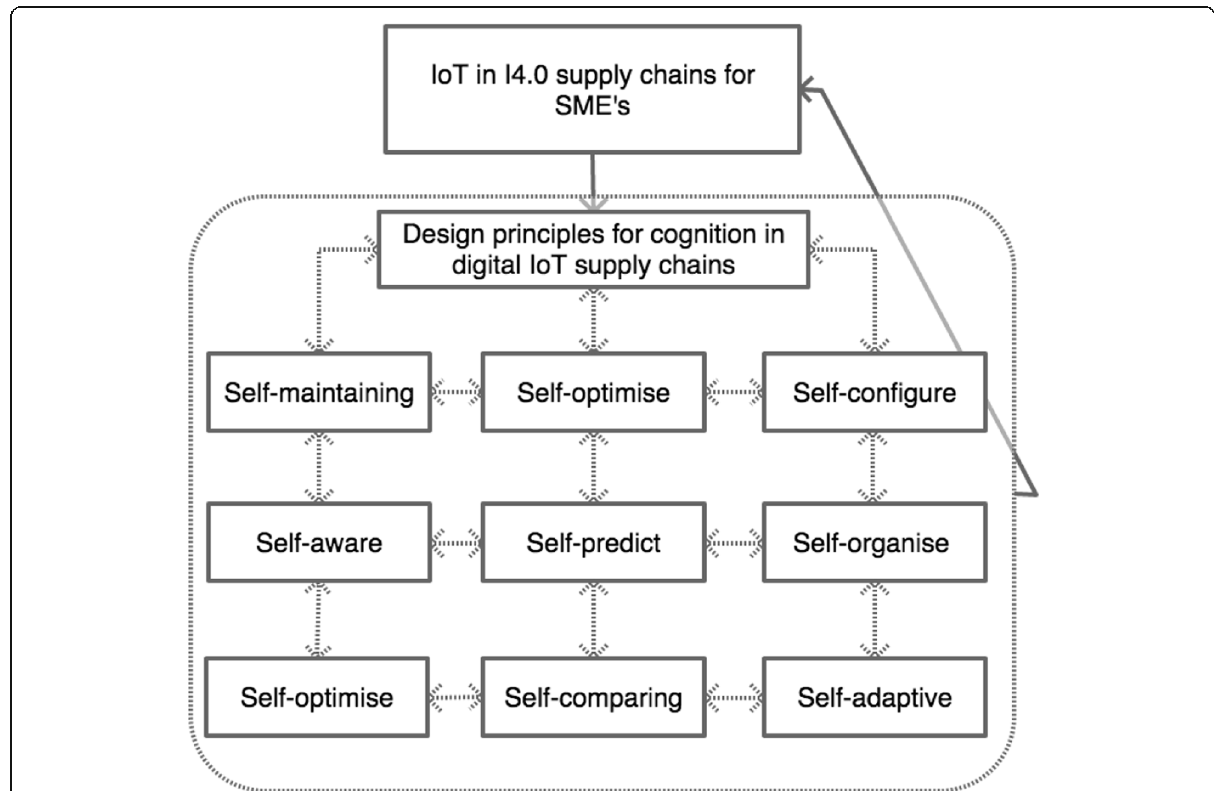
Fig. 1 Iterative learning and improvement in design principles – synthesised from the taxonomic